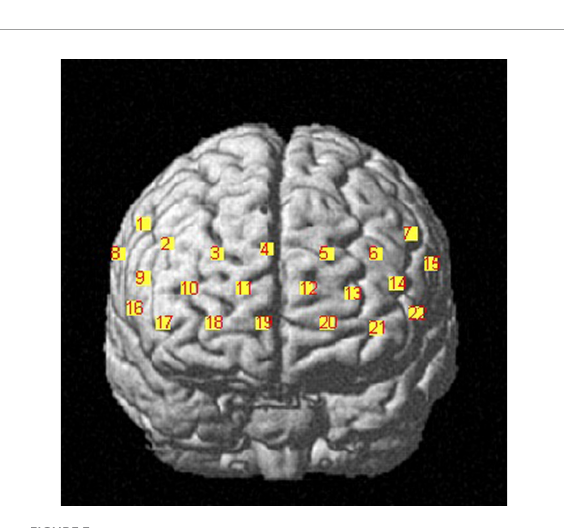
FIGURE3 Frontal view of the corresponding anatomical regions of channel configuration. fNIRS data are recorded from the prefrontal cortex, including the right dorsolateral prefrontal cortex, left dorsolateral prefrontal cortex and frontopolar area, localized by the MNI 10-10 system and 3D digitizer.